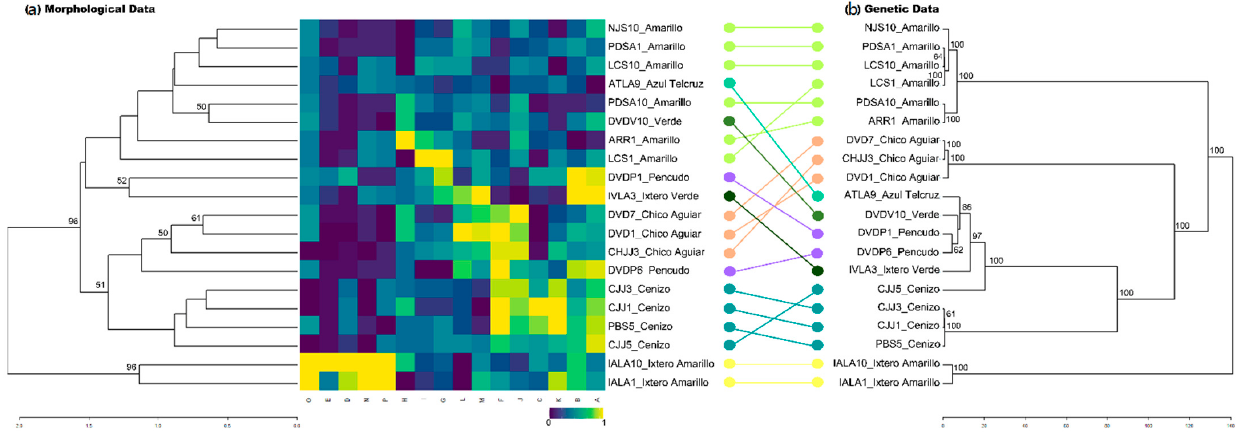
Figure 4. Dendrograms obtained with the morphological ( a ) and genetic ( b ) 23% subset data. ( a ) Morphological dendrogram and heatmap with normalized values to a range 0–1. Variables are: (A) plant length, (B) leaf length, (C) leaf width at middle, (D) terminal thorn length, (E) terminal thorn base width, (F) number of lateral teeth, (G) distance between teeth, (H) teeth length, (I) Distance between teeth/leaf length, (J) number of lateral teeth/leaf length, (K) terminal thorn length/terminal thorn base width, (L) leaf length/terminal thorn length, (M) leaf length/leaf width at middle and Munsell coordinates (N) xyY.x, (O) xyY.y and (P) xyY.Y.